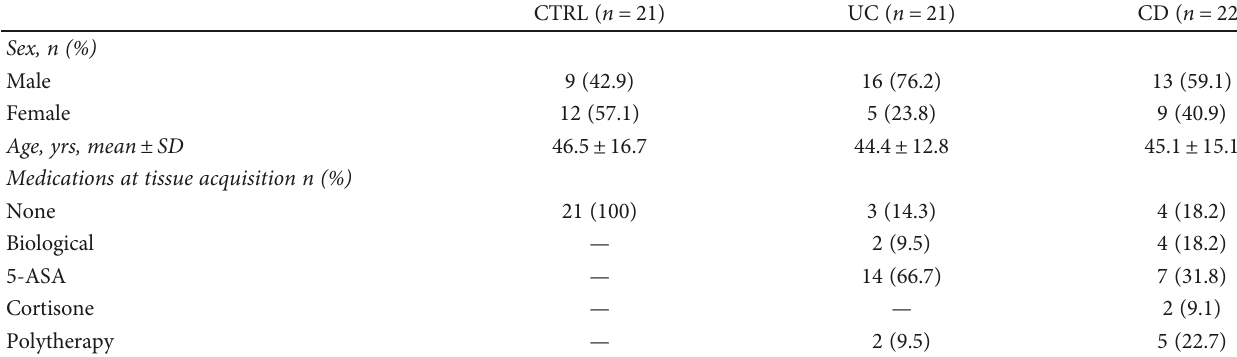
Table 1: Clinical and demographical parameters of individuals involved in the